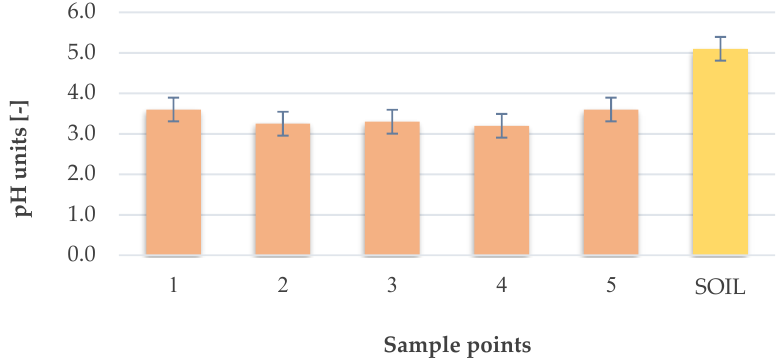
Figure 11. Values of pH in the samples, Ilba mining area.